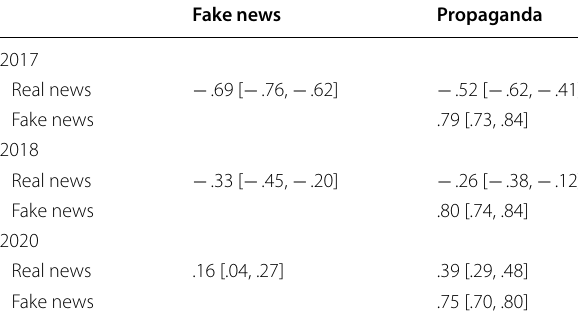
Table 2 Averaged real news, fake news, and propaganda rating correlations